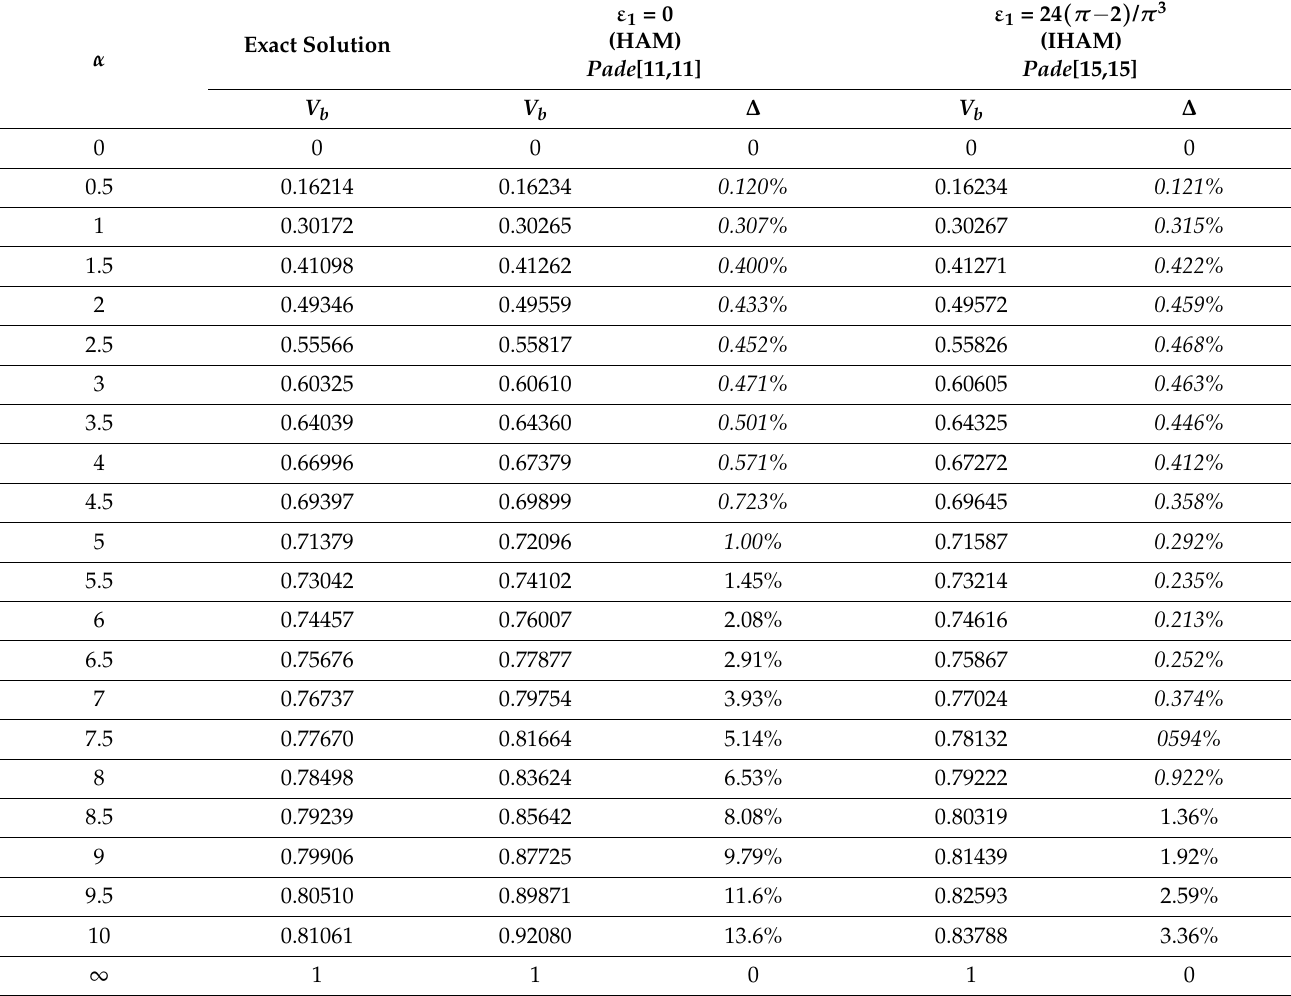
[ P ] of homotopy-P á de approximation by IHAM. ( n = 30, ε = 8/ π 2 b